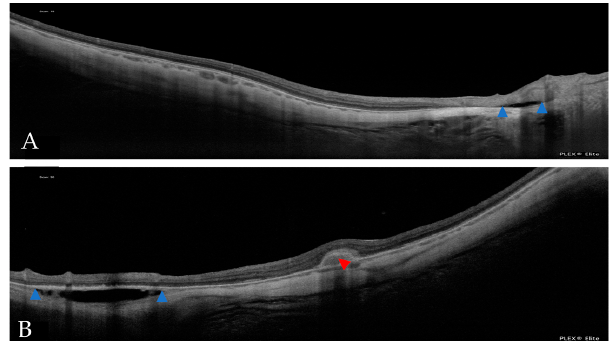
Figure 11. ( A ) In an OCT scan, the blue arrowheads indicate scleral dehiscence. The red arrowheads indicate a Fuch´s spot. ( B ) In an OCT scan, the red arrowheads indicate the macular pit. Six eyes had scleral dehiscence without a macular pit. Scleral dehiscence and macular pits were both found in areas of chorioretinal atrophy. Choroidal cavitation was detected in six eyes (Figure 12).